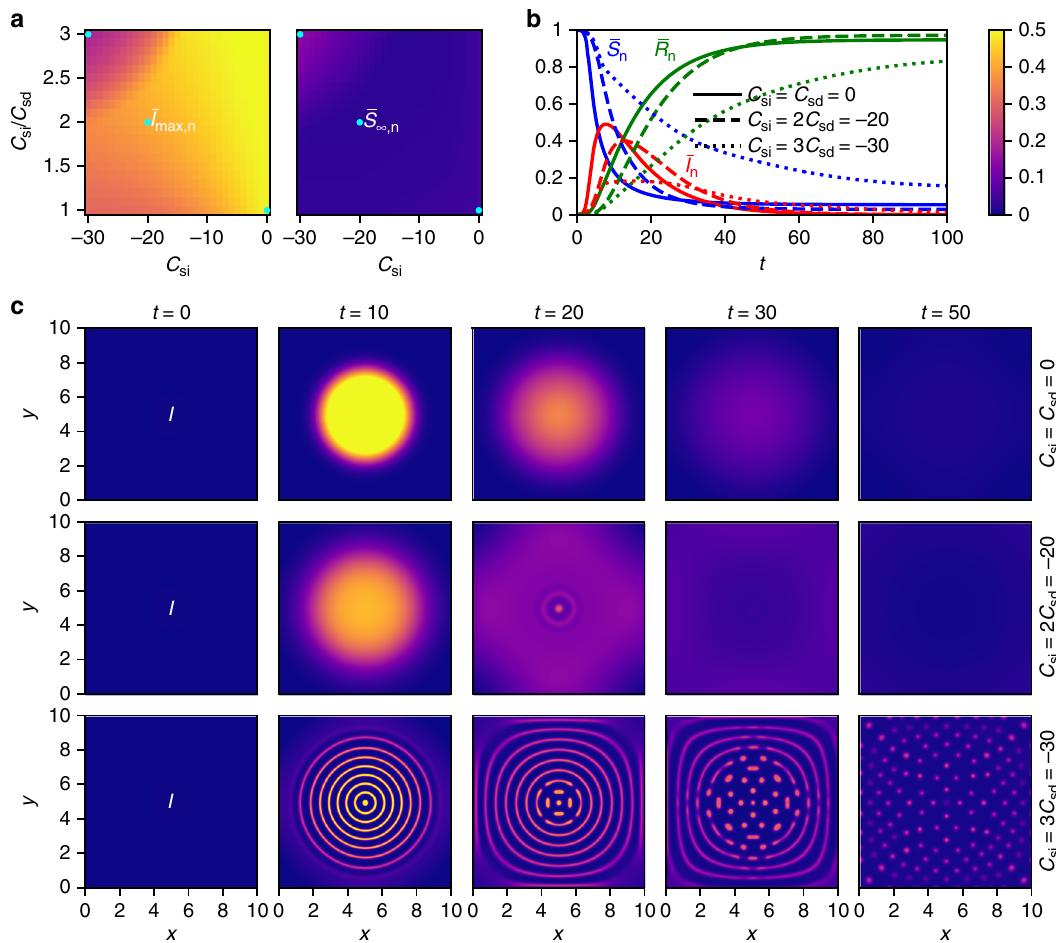
Fig. 1 Phase diagrams and time evolutions for the SIR-DDFT model. a The shown phase diagrams reveal the dependence of the maximal fraction of infected persons (cid:2) I max ; n and the fi nal fraction of susceptible persons (cid:2) S 1 ; n on the strength of self-isolation C si and social distancing C sd . A phase boundary is clearly visible. Blue points correspond to the time evolutions presented in the following sub fi gures. b Time evolutions of the fractions of susceptible ( (cid:2) S infected ( (cid:2) I n ), and recovered ( (cid:2) R n ) persons are shown for no interactions ( C si = C sd = 0), moderate interactions ( C si = 2 C sd = − 20), and strong interactions ( C si = 3 C sd = − 30). It can be seen that a reduction of social contacts fl attens the curve (cid:2) I same three interaction strengths at different times t . For the strongest interactions, phase separation ( fi rst into rings, then into single spots) is observed. The color bar applies to Figs. 1a and